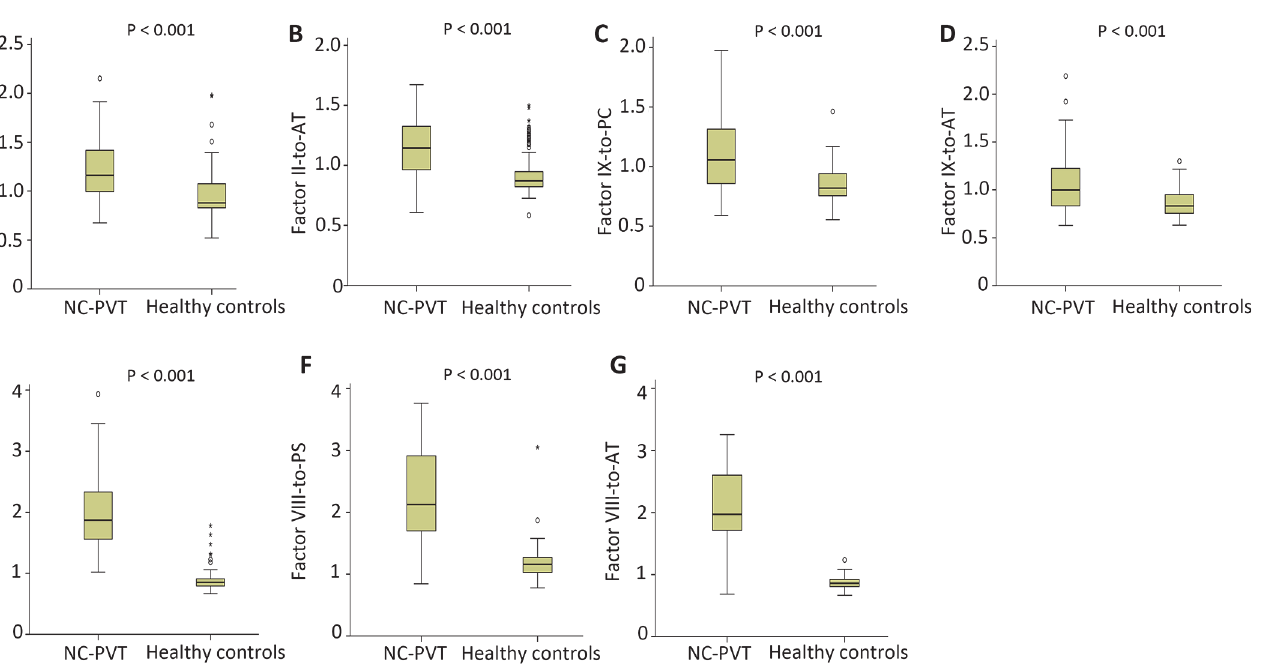
Fig 2. Box plots for the increased ratios in patients with non-cirrhotic portal vein thrombosis (NC-PVT) and healthy